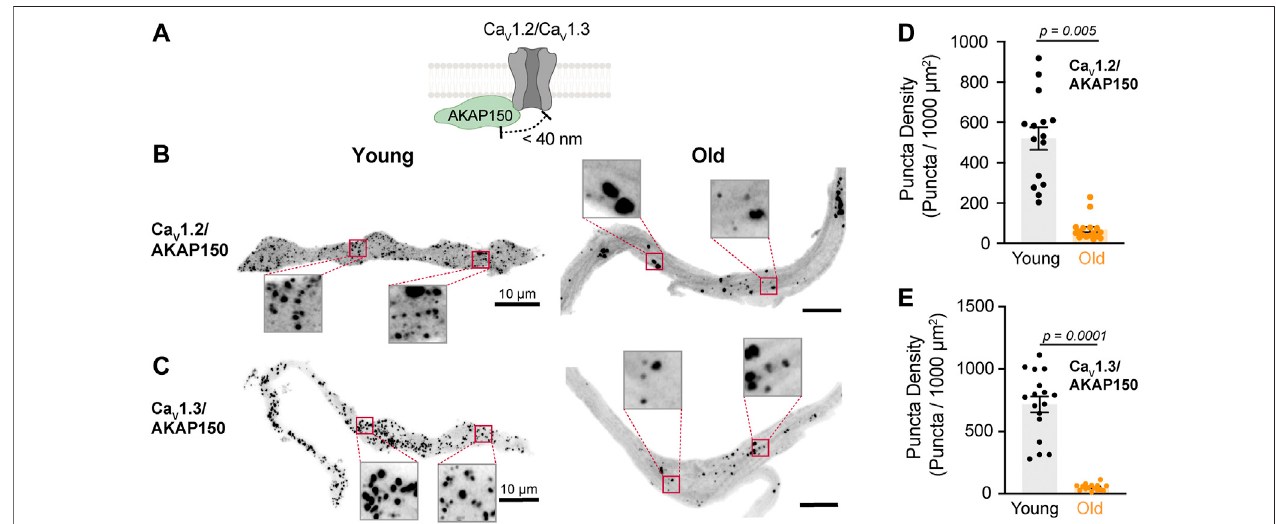
FIGURE 4 | Aging reduces the association between L-type calcium channels and AKAP150. (A) Diagrammatic representation of the molecular association being tested between AKAP150 and speci fi c LTCCs. Diagram created with BioRender.com. (B) Representative PLA pictures between AKAP150 and Ca V 1.2 channels in young and old pacemaker cells. (C) Representative PLA pictures between AKAP150 and Ca V 1.3 channels in young and old pacemaker cells. (D) Comparison of the puncta density formed by the association of AKAP150 with Ca V 1.2 between young (n = 15, N = 3 mice) and old (n = 17, N = 3 mice) pacemaker cells. (E) Comparison of the puncta density formed by the association of AKAP150 with Ca V 1.3 channels between young (n = 15, N = 3 mice) and old (n = 17, N = 3 mice) pacemaker cells. Statistical comparison used an unpaired t-test with signi fi cance at p < 0.05.